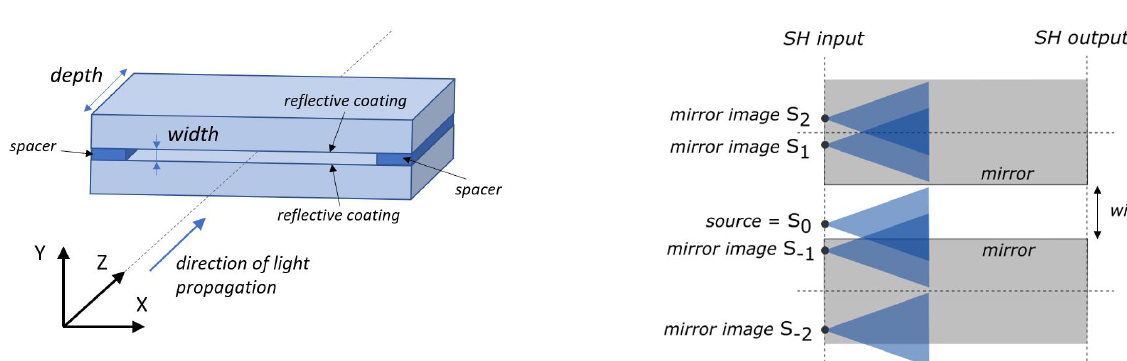
Figure 2. The slit homogenizer is composed of two parallel mir- rors separated by spacers. The slit opening is defined by its length ( X dimension) and width ( Y dimension) as for a regular slit. The slit homogenizing function comes from the third dimension (depth), where multiple reflections homogenize the illumination.